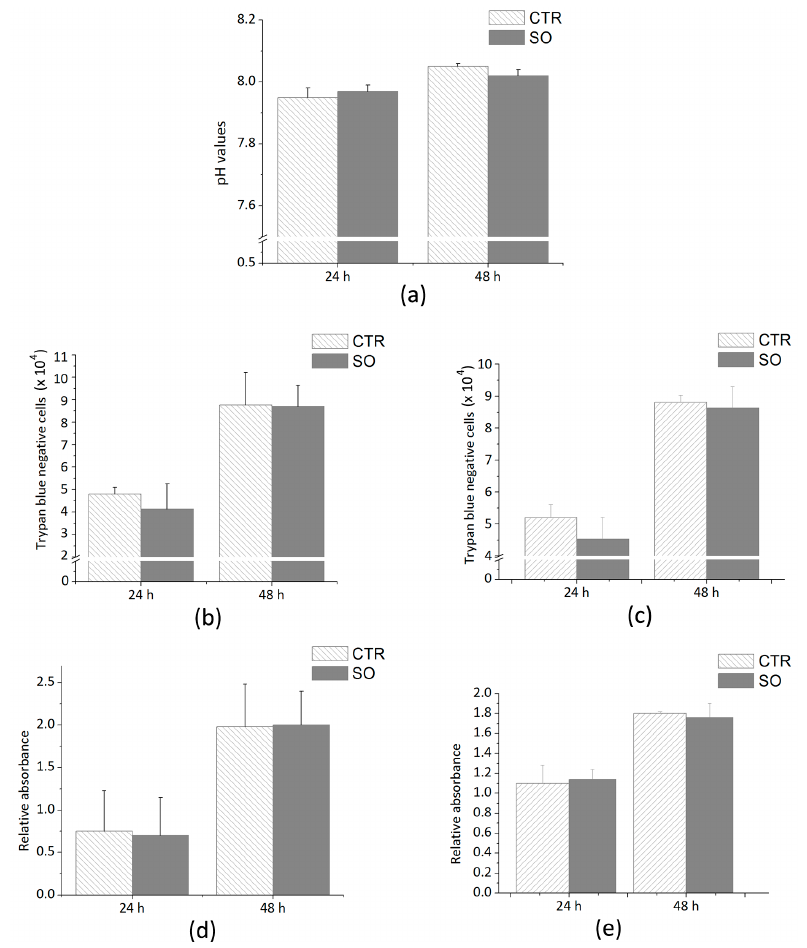
Figure 3. ( a ) pH values of the samples with medium alone (= CTR) or with scleral ossicles (= SO) after 24 h and after 48 h. Number of trypan blue negative cells, 1G11 ( b ) and 2T3 ( c ), counted in samples with (SO) or without (CTR) the scleral ossicles. MTT absorbance related to the number of cells, 1G11 ( d ) and 2T3 ( e ), respectively, counted in samples with (SO) or without (CTR) the scleral ossicles. Data were calculated by three independent experiments and presented as the mean ± SD. p > 0.1 is not statistically